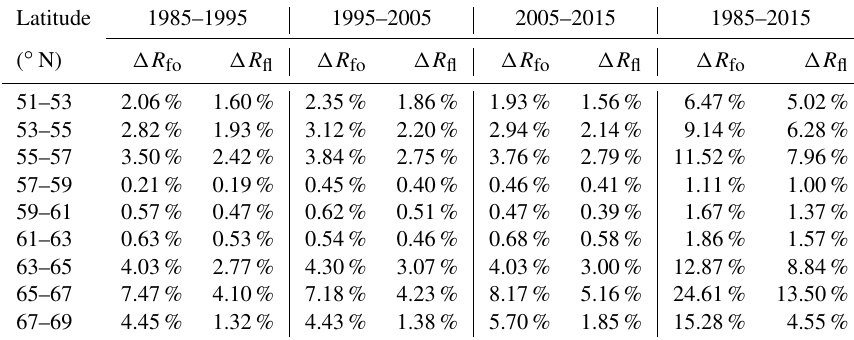
Table 2. Quantitative details of the changes in boreal forest coverage in each latitude zone.